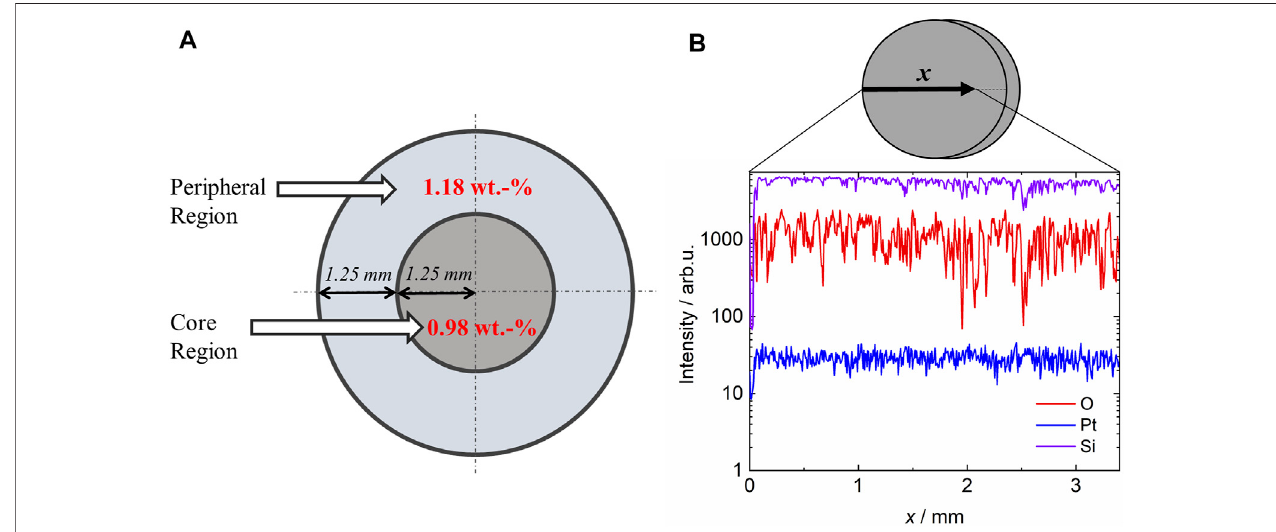
FIGURE 5 | (A) The distribution of Pt measured via elemental analysis determined at the peripheral and core regions of the monolith cross section (sample: MonoCat-10). (B) SEM-EDX line scan depicting a homogeneous radial distribution from the periphery to the center of the monolith cross section (sample: MonoCat-1).